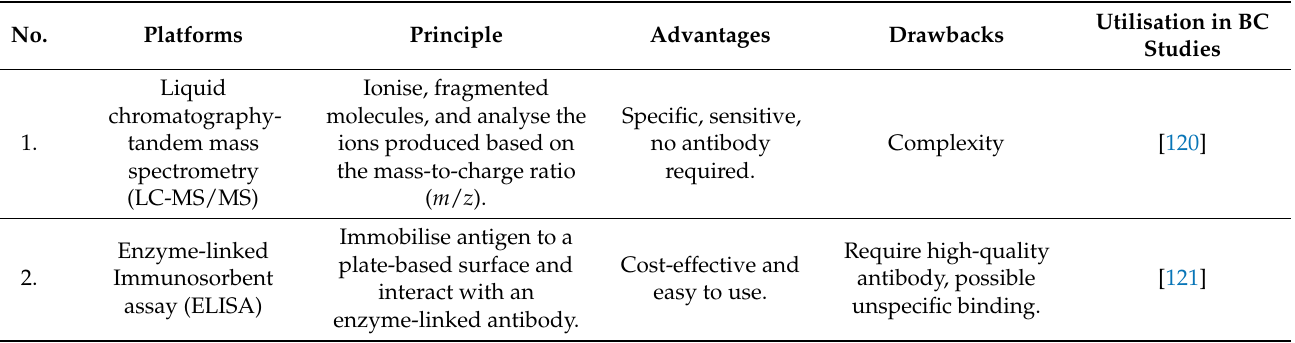
Table 4. Proteomic platforms of biomarker